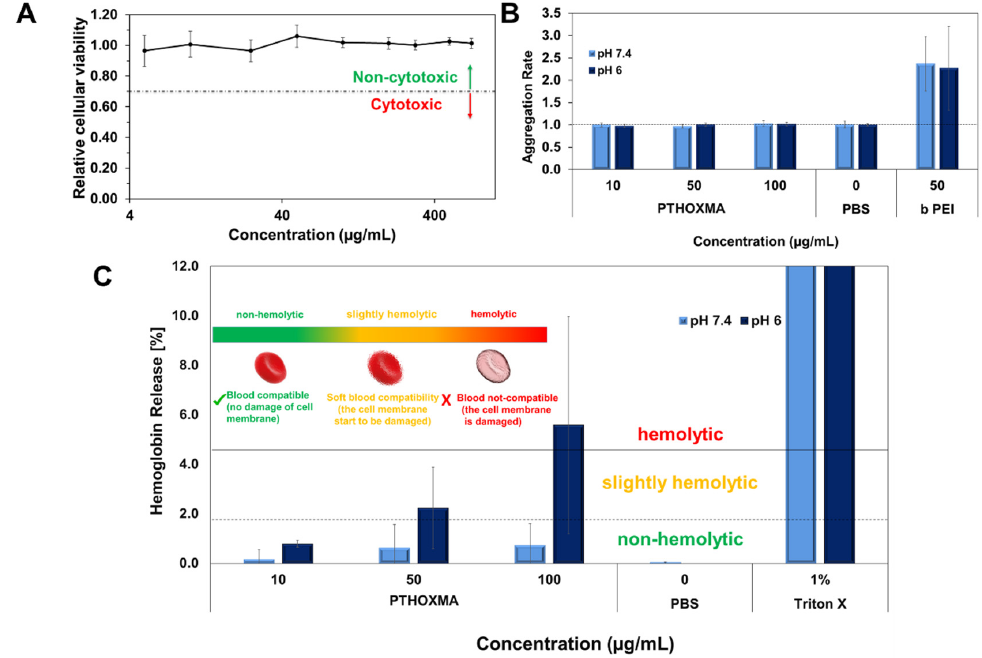
Figure 6. ( A ): Cellular viability results of PTHOXMA on fibroblast cell line L929 (at pH 7.4); ( B ): Aggregation activity of PTHOXMA ; ( C ): Haemolytic activity of PTHOXMA evaluated by the release of haemoglobin from sheep blood erythrocytes.